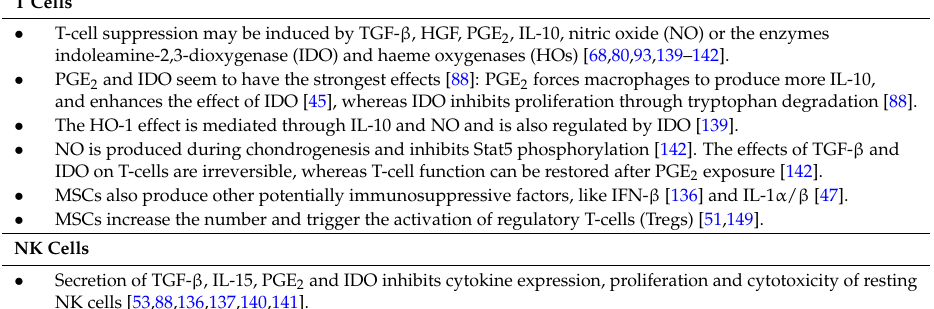
Table 5. Important effects of MSC on immunocompetent cells.